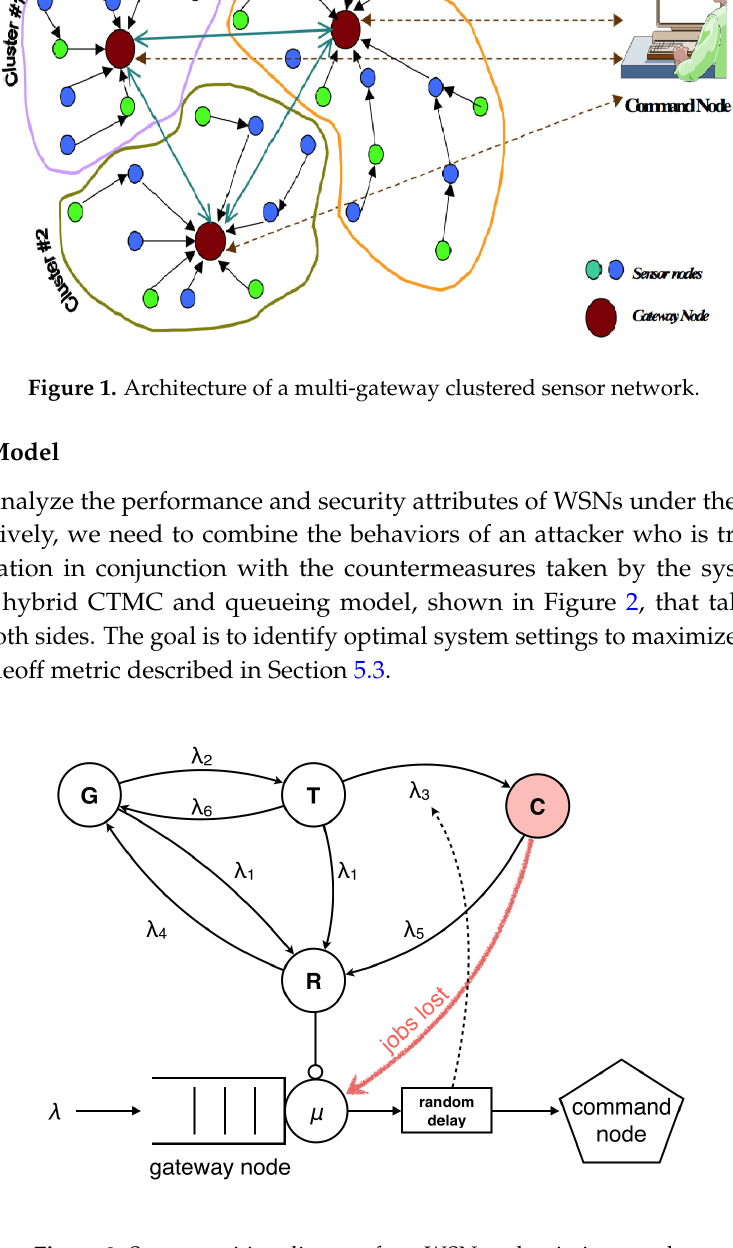
Figure 2. State transition diagram for a WSN under timing